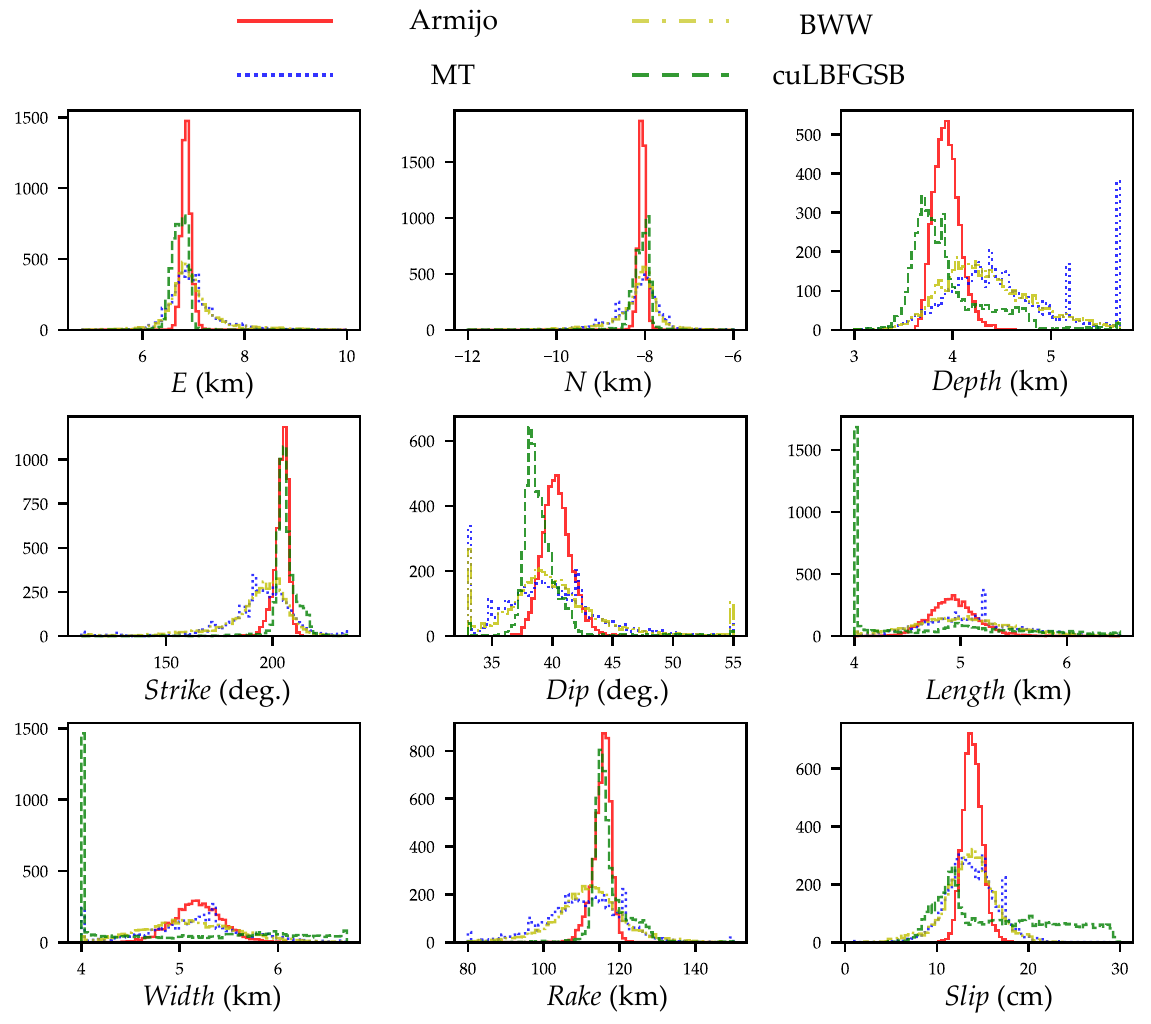
Figure 11. Parameter distribution of the Monte Carlo results. Therefore, as the final step, we verified the correctness of our source parameter esti- mation framework with the best-fit parameters derived by Armijo. Figure 12 compares the geodetic displacement and the modeled displacement acquired from the final source parameters. Each row of the figure represents the surface displacement for the E–W direc- tion, the N-S direction, and the depth direction. The third column also shows the residual displacement between the geodetic and the modeled displacements. The residual displace- ment demonstrates that our proposed framework approximates the geodetic displacement quite precisely, where the RMSE for each direction is 0.49, 0.31, and 0.33 cm for the E–W, the N–S, and the depth direction,